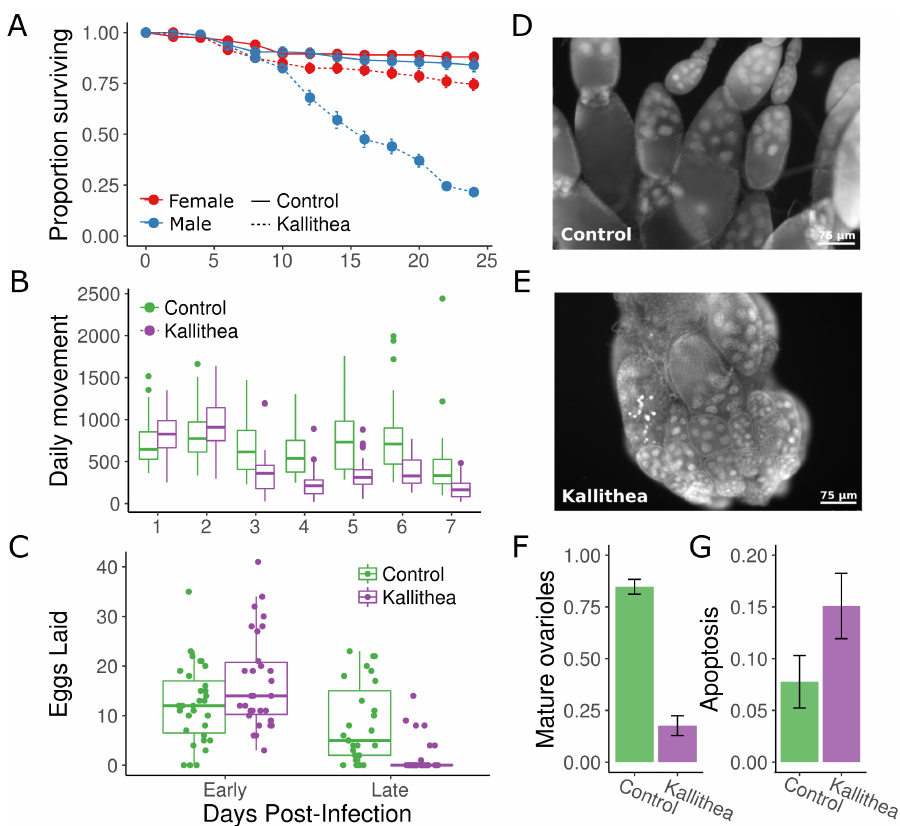
Fig 2. KV causes male-biased mortality, increased lethargy, and decreased fecundity. (A) Injection of KV virus into OreR flies led to sex-specific mortality. Infected females (red dotted line) experienced a small but significant increase in mortality, but males (blue dotted line) experienced a significantly larger rate of mortality after day 10. Flies injected with control gradient solution were unaffected (solid lines). Each point is the mean and standard error for the proportion of flies alive in each vial (10 vials of 10 flies). (B) Although females remained alive for longer, they were more lethargic. We assessed daily movement of flies injected with either chloroform-inactivated KV (green) or active KV (purple). KV-infected flies moved less from days 3–7 post-infection. (C) Females also displayed altered egg laying behaviour. Thirty pairs of flies were injected with inactive chloroform treated KV (green) or active KV (purple). KV- infected flies laid a slightly, but not significantly, higher number of eggs during early infection (1 and 2 DPI) but laid significantly fewer eggs in late infection (7 and 8 DPI). This reduction in egg laying is due to a shutdown of oogenesis before vitellogenesis (D, E), and ovaries from KV-infected flies house a lower proportion of ovarioles that include late- stage and mature egg chambers (F) and a higher proportion which contain apoptotic nurse cells (G). Ovaries were analysed 10 DPI, and error bars (F,G) show the standard error.